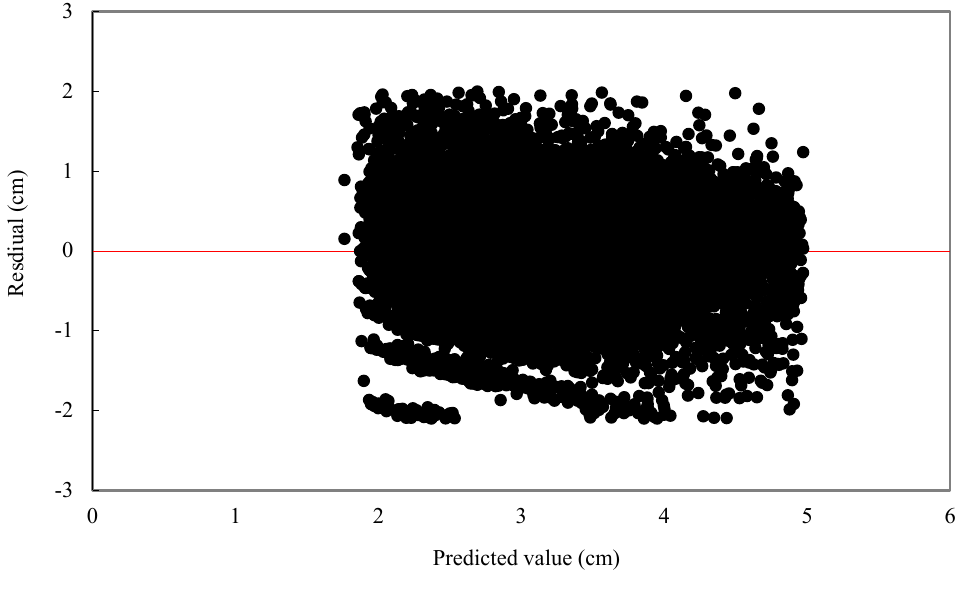
Figure 3. Weighted residuals and predicted values of diameter growth model.